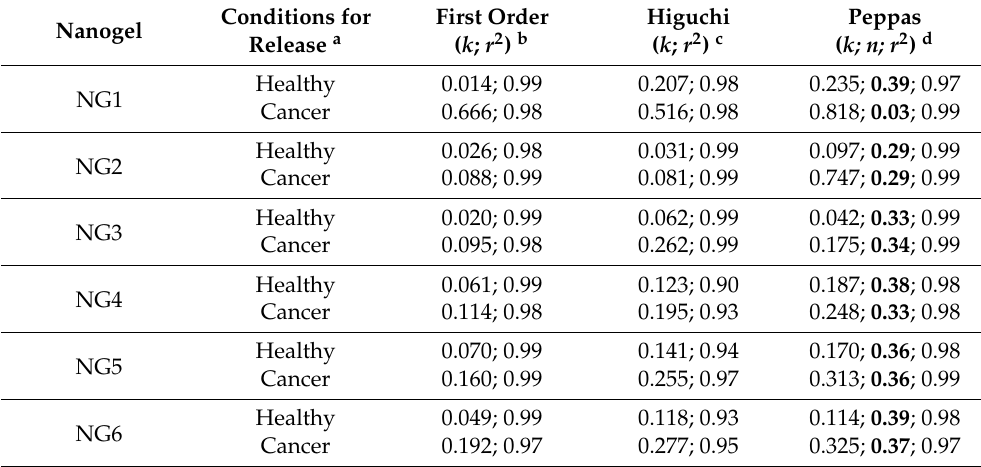
Table 2. Release rate for CDDP: in vitro release data fitted with different models.